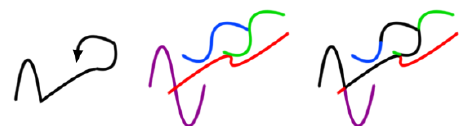
Figure 4. Defining a gesture through a sequence of